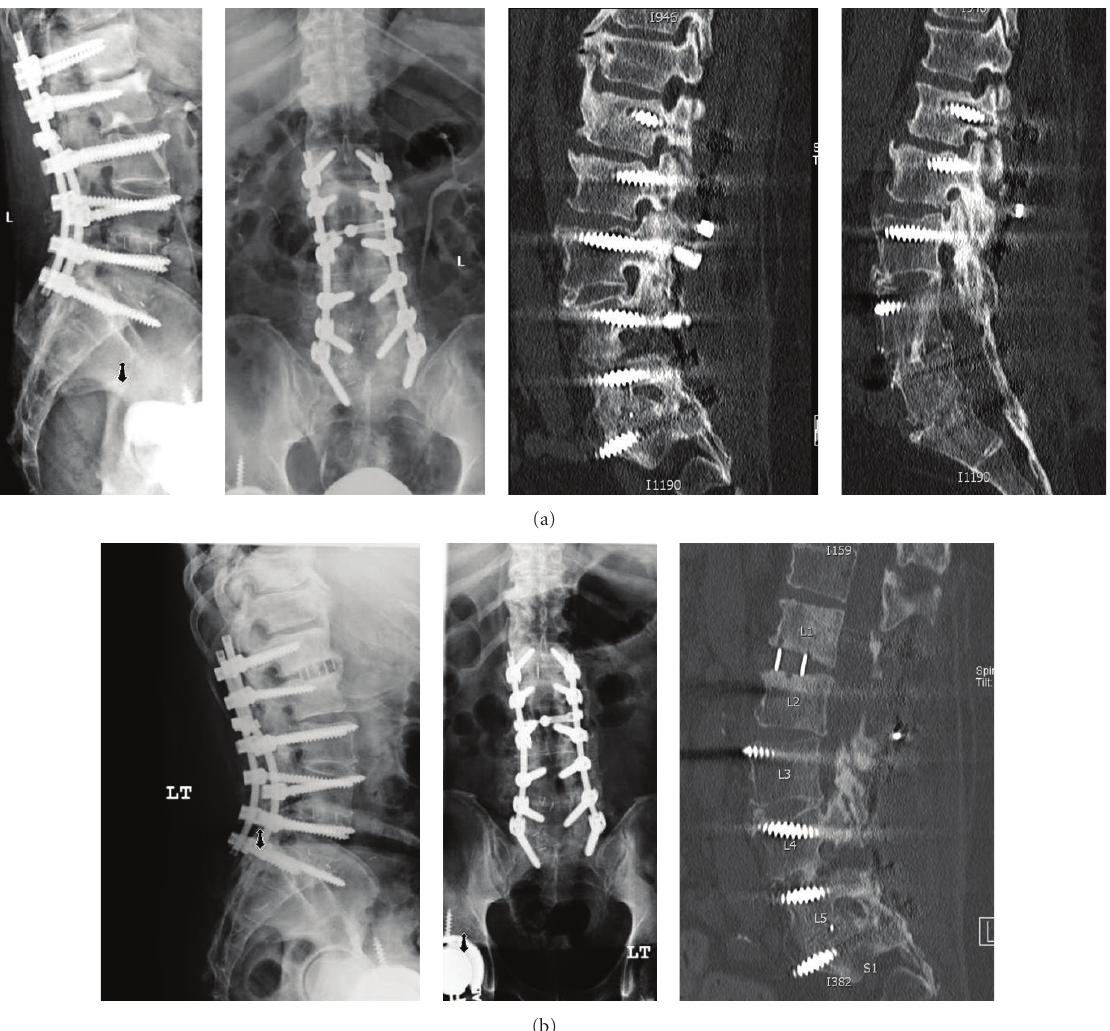
Figure 1: (a) Preoperative X-rays demonstrating nonunion at L1-2 after posterior instrumented fusion and decompression from L1-S1. (b) Postoperative X-rays demonstrating XLIF at